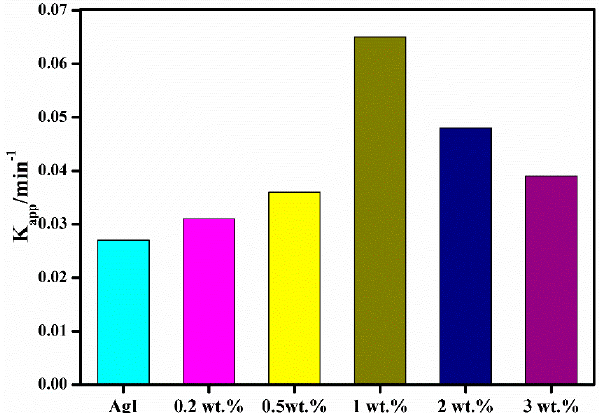
Figure 8. First-order rate constants with various TCNQ contents.